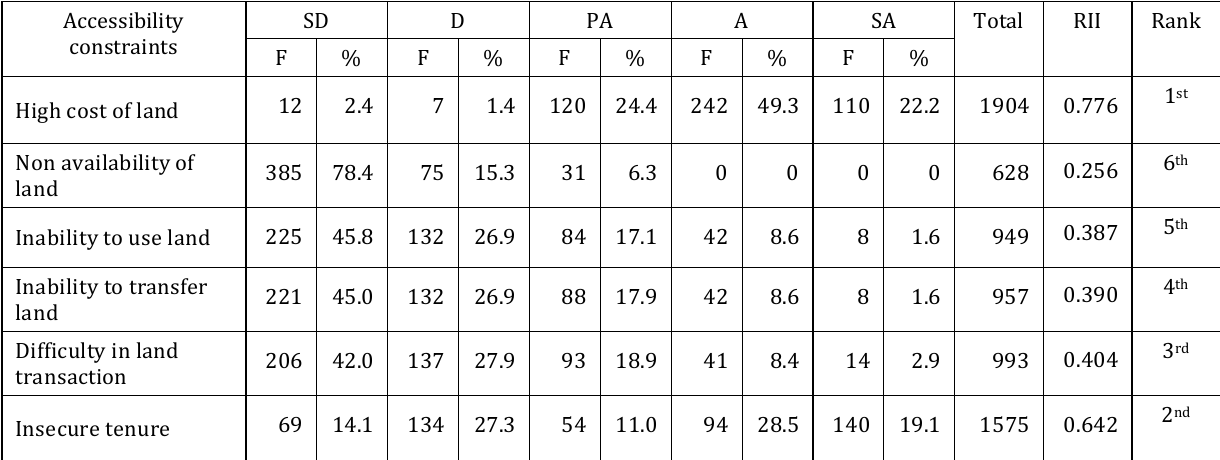
Table 5. The relative extent to which each constraint influences land accessibility for migrants